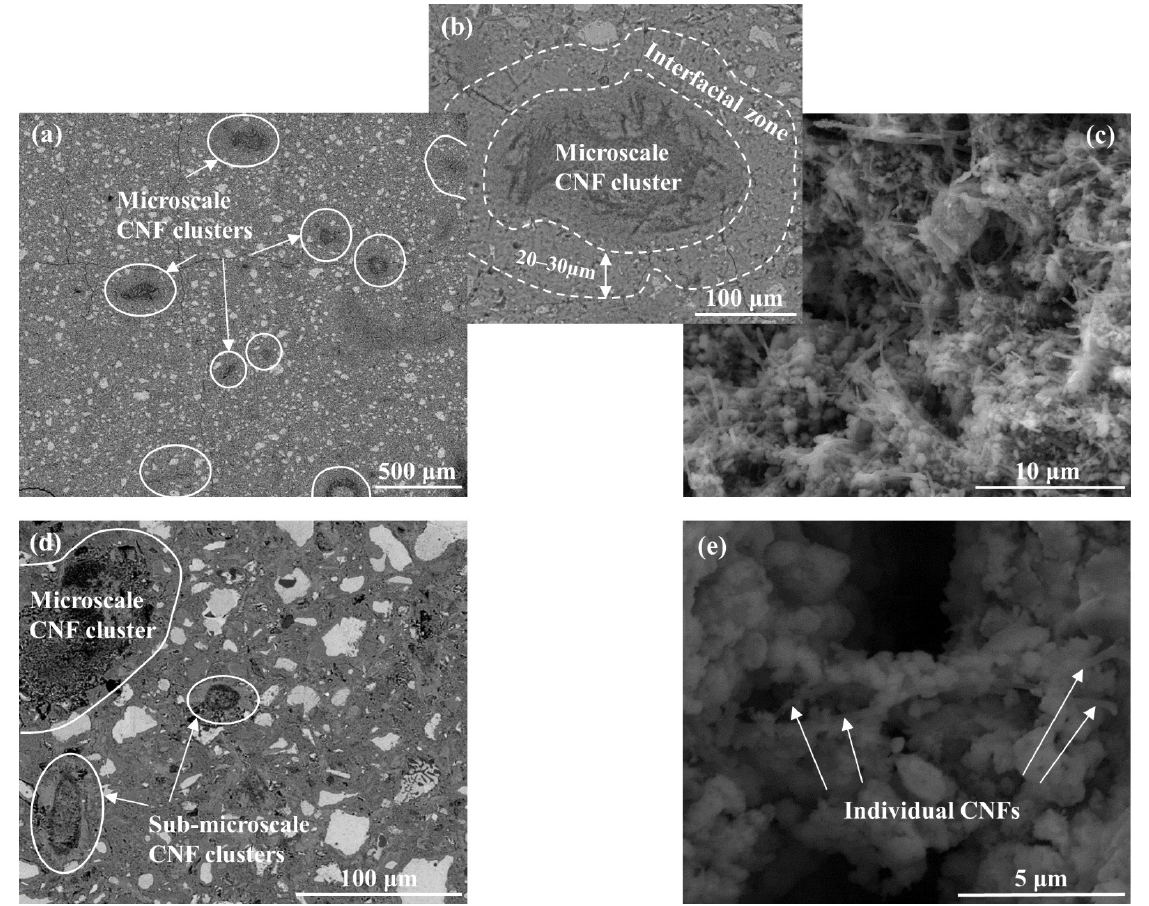
Figure 2. SEM images showing ( a ) the distribution of microscale CNF clusters in cement paste, ( b ) an individual CNF cluster and surrounding interfacial zone, ( c ) the entangled mass of CNFs and cement hydrates within a cluster, ( d ) the distribution of sub-microscale CNF clusters in cement paste, and ( e ) individual CNFs that were well embedded in the cement paste.